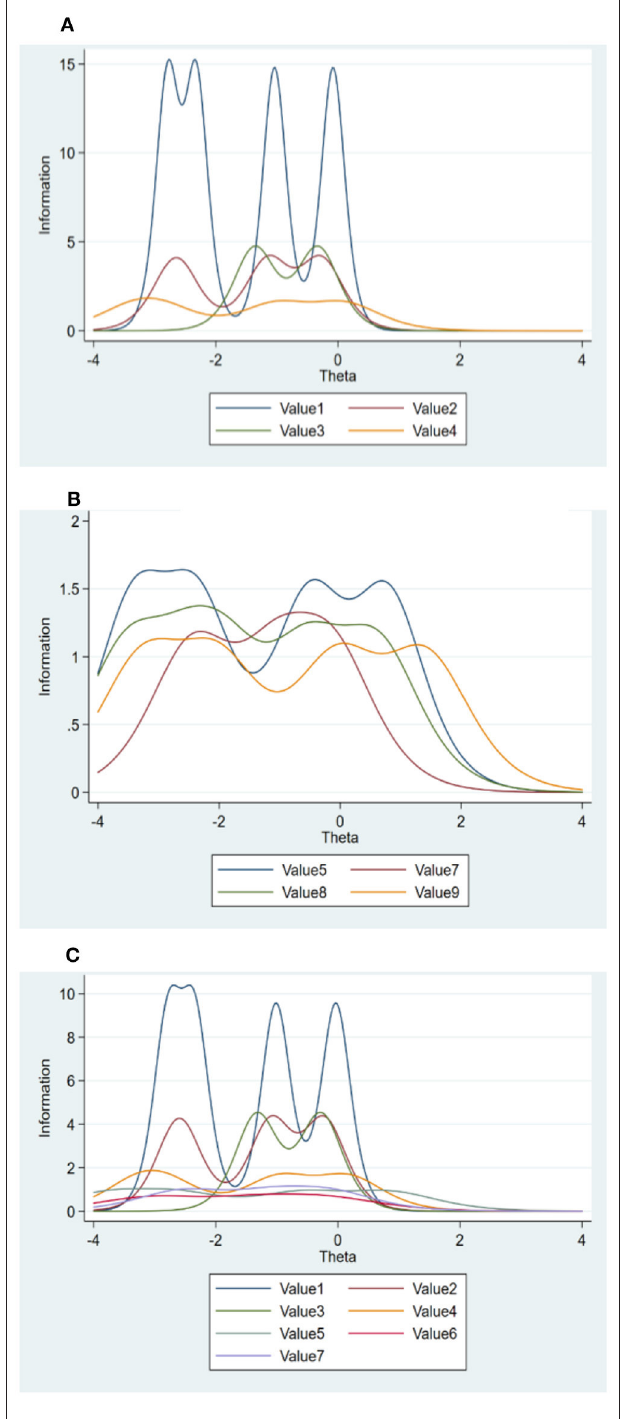
FIGURE 1 | Strength of salience or sensitivity of human value (human concerns). (A) Item information function (Biosphere). (B) Item information function (Altruism). (C) Item information function